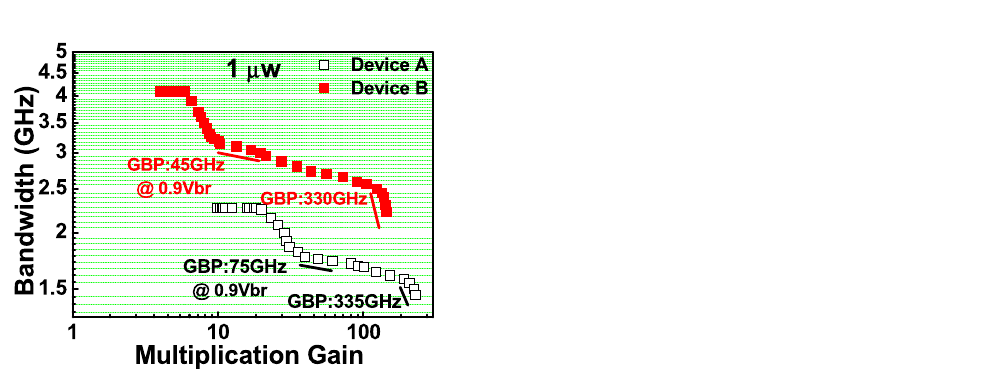
Figure 6. Measured bias dependent O-E frequency responses under 250 µW optical pumping power of: ( a ) Device A. ( b ) Device B.